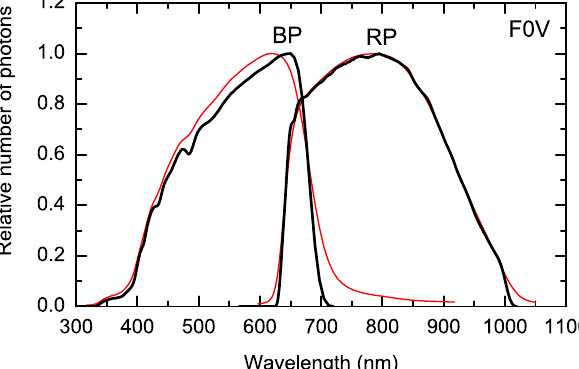
Fig. 3. The same as in Figure 1 but for F0 V type